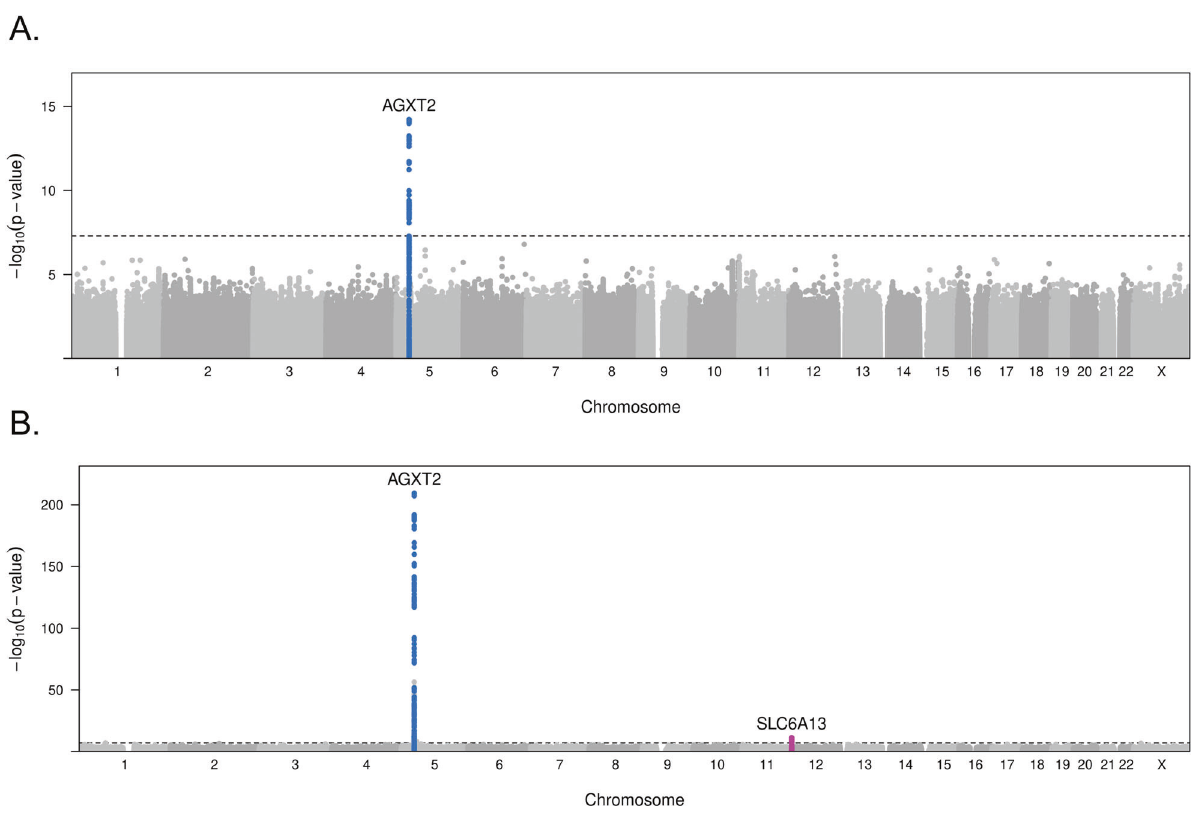
Fig. 2 Manhattan plots from GWAS of MCI-MRS and of BAIBA. Manhattan plots of GWAS for A MCI-MRS ( n = 3890) and B BAIBA ( n = 3863) in HCHS/SOL. Every point corresponds to a genetic variant, and the height of the point is the − log(association p value) from the MCI-MRS or BAIBA association analysis with p values from the score